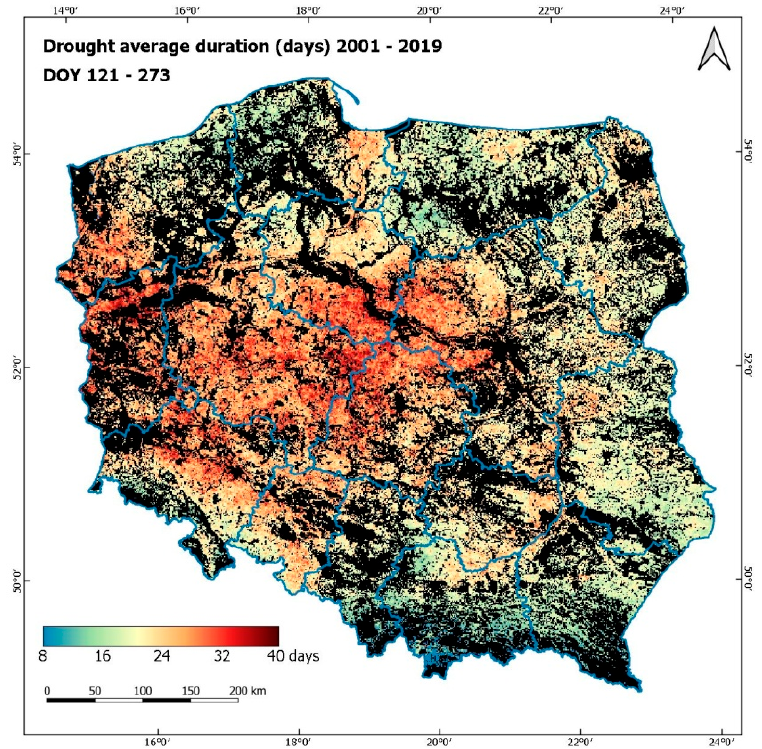
Figure 25. Average duration of drought in the 2001–2019 period.